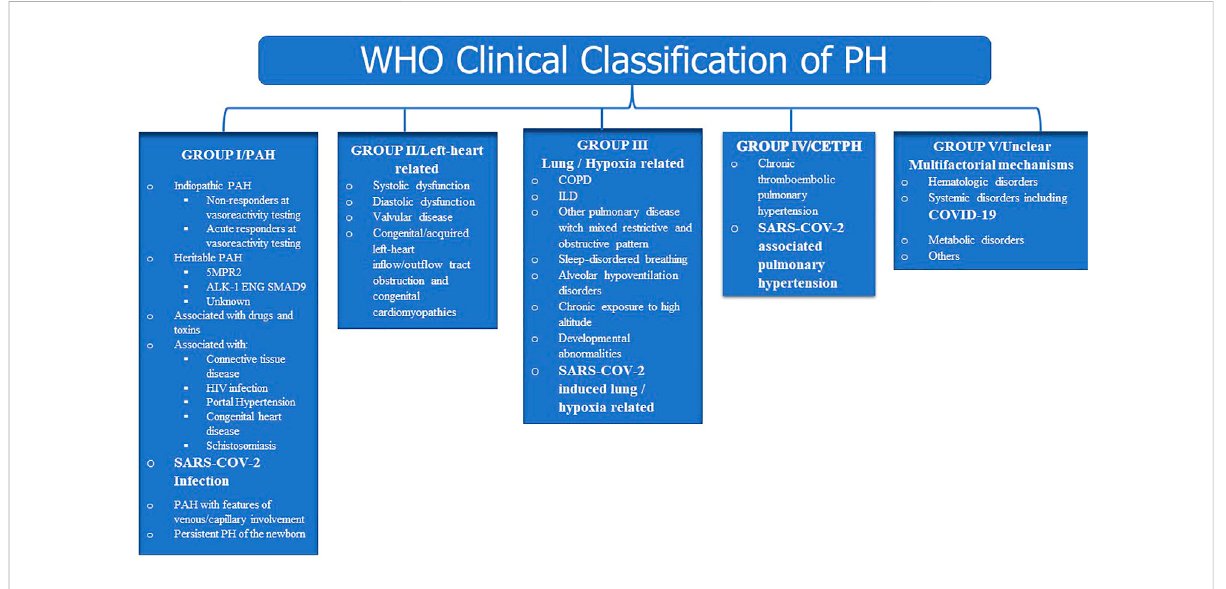
Suggested clinical classi fi